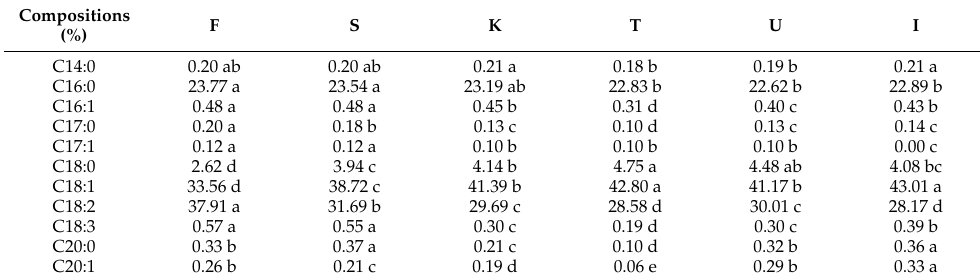
Table 1. Average content of ASO composition in developing A. trifoliata seeds. Different letters represent significance at p ≤